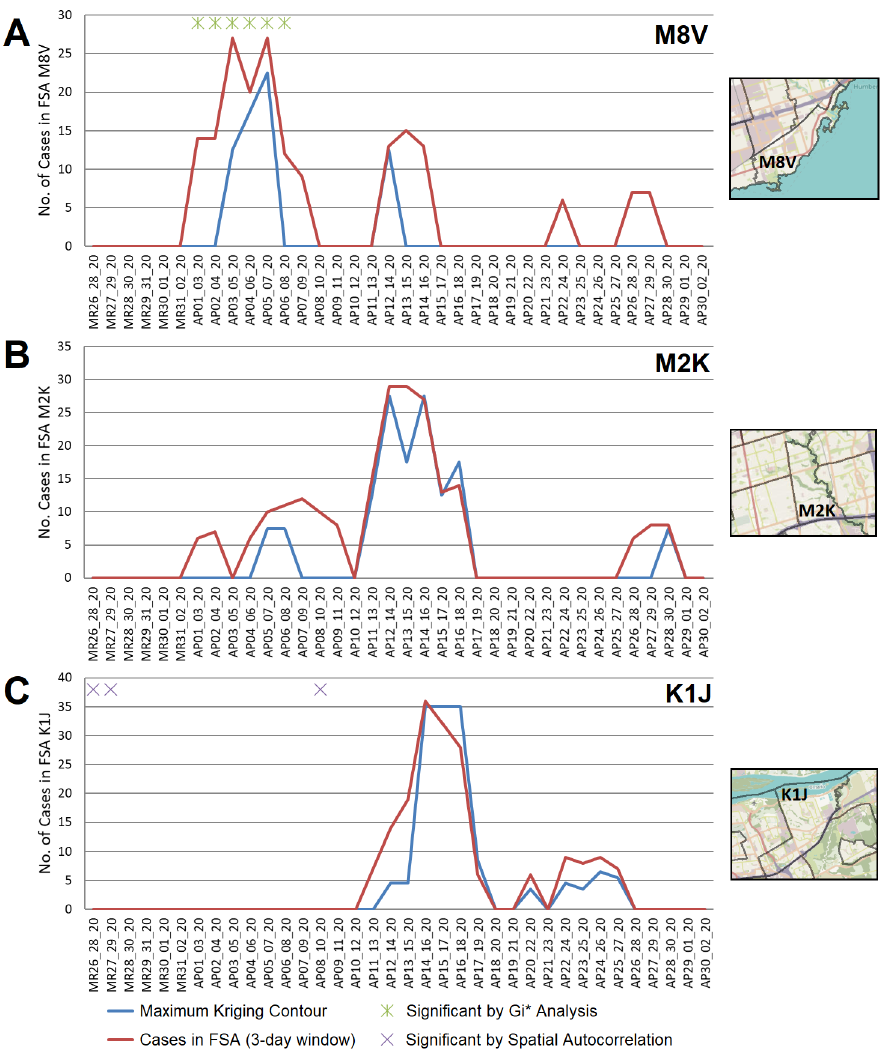
Figure 5. Geostatistical analysis of COVID-19 outbreaks during wave 1. FSAs exhibiting high-disease burden by Gi* analysis were identified with localized hotspots by kriging or as having significant case clusters by Spatial Autocorrelation. Panels indicate cases in all PCs within FSAs (A) M8V (B) M2K, and (C) K1J, which were amalgamated over 3-day sliding windows and masked (red line indicates actual case counts; privacy consideration require dates with fewer than 5 cases to be masked as zero). Kriging interpolated the number of cases over these FSAs (blue line), whichcloselyapproximatestruecasecountswhencountsarehigh.Greenasterisksindicatedateswhereatleastone day within a 3-day window was significant by Gi*; purple crosses indicate significantly clustered cases within